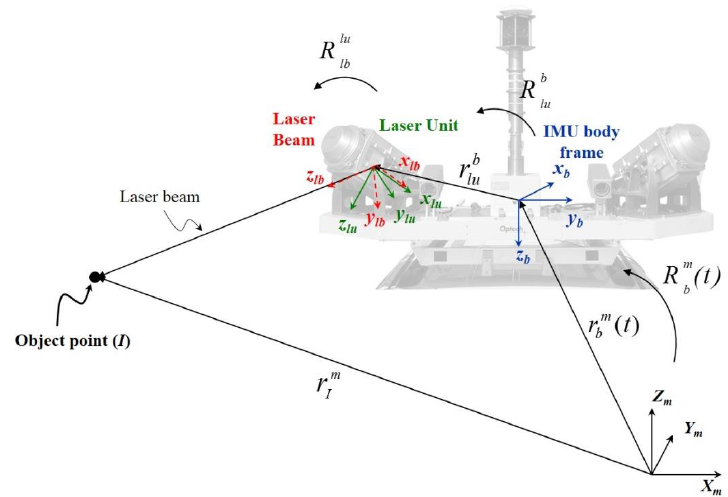
Figure 1 . Involved quantities in the lidar system geometric